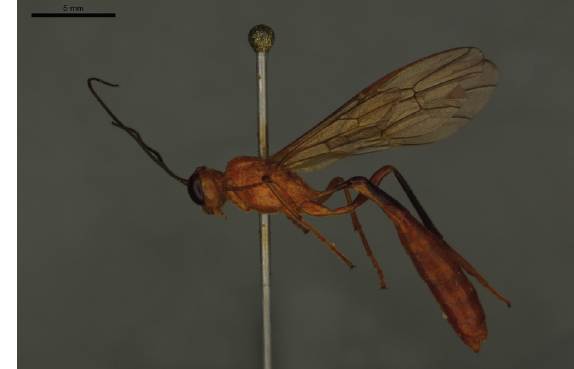
Figure 3 - Castrosion renei gauld & Bradshaw, 1997, female habitus.